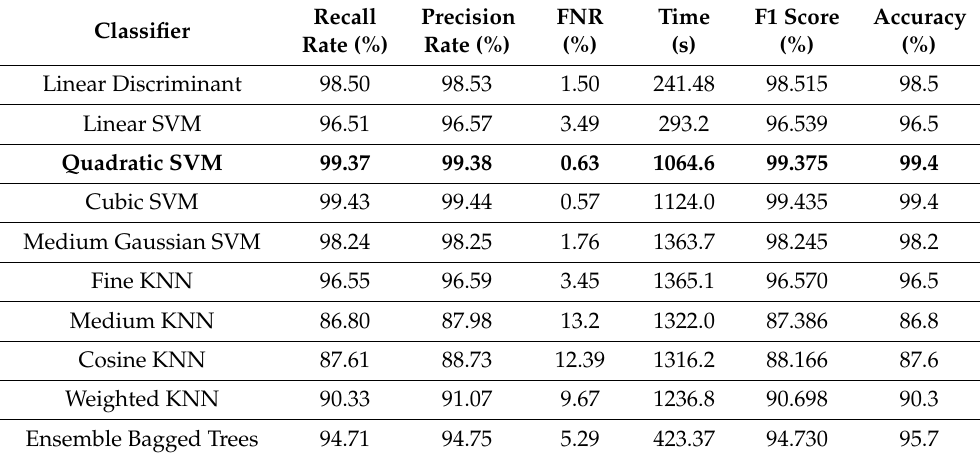
Table 9. Achieved results on WVU dataset after best feature selection using KcWKNN. The bold represents the best obtained